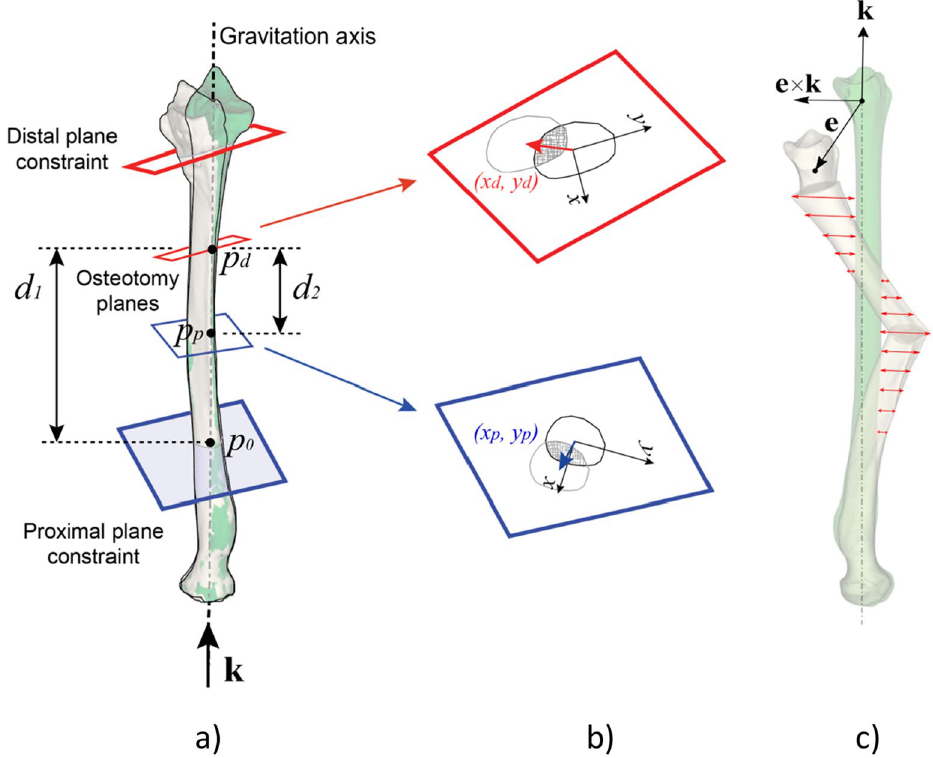
Figure 5. Definition of the parameters involved in optimizing translational alignment of an affected bone with a proximally aligned target bone (green). ( a ) The direction of the gravitation axis of the target bone is represented by unit vector k . During the optimization procedure the distal and proximal plane positions are defined by ( d 1 , d 2 ), as measured along the gravitation axis of the bone. The large planes define the search range for the osteotomy planes and are set by the user. The orientation of a distal search plane ( n d ) is quantified by azimuth and elevation angles ( φ d , ψ d ) and the rotation of the distal segment is equal to β d (see Fig. 1). The proximal plane orientation and bone rotation follow by calculation ( R p = R c R d −1 and Eqs. 3 and 4). ( b ) In-plane translations of the distal and proximal bone segments are defined in the sideward and upward ( x, y ) direction of the bone cross section. The shaded surface areas represent the amount of bone overlap. ( c ) Vector e represents the residual translation error of the distal bone segment and is used to calculate the error in the length and transverse direction (see text). The mean of the nearest-neighbor distances (red lines) between mesh points of the middle-proximal bone assembly and the target bone (green) is used to control alignment of these bone segments ( e m in Eq.